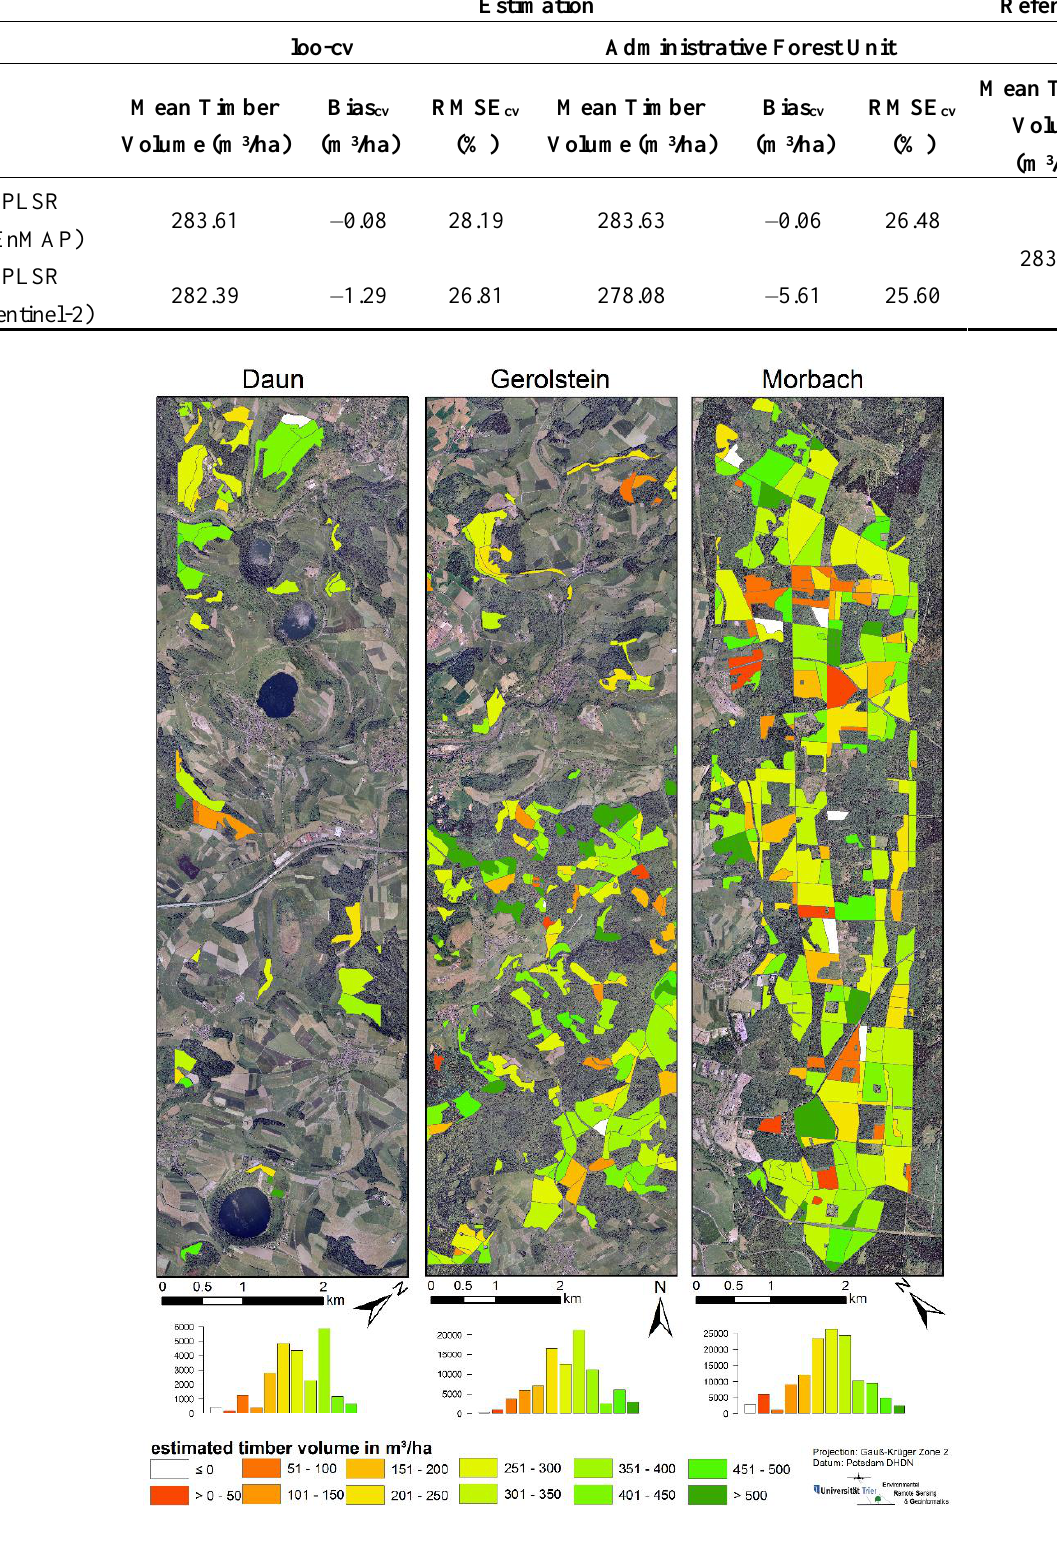
Figure 9. Timber volume distribution map based on FID